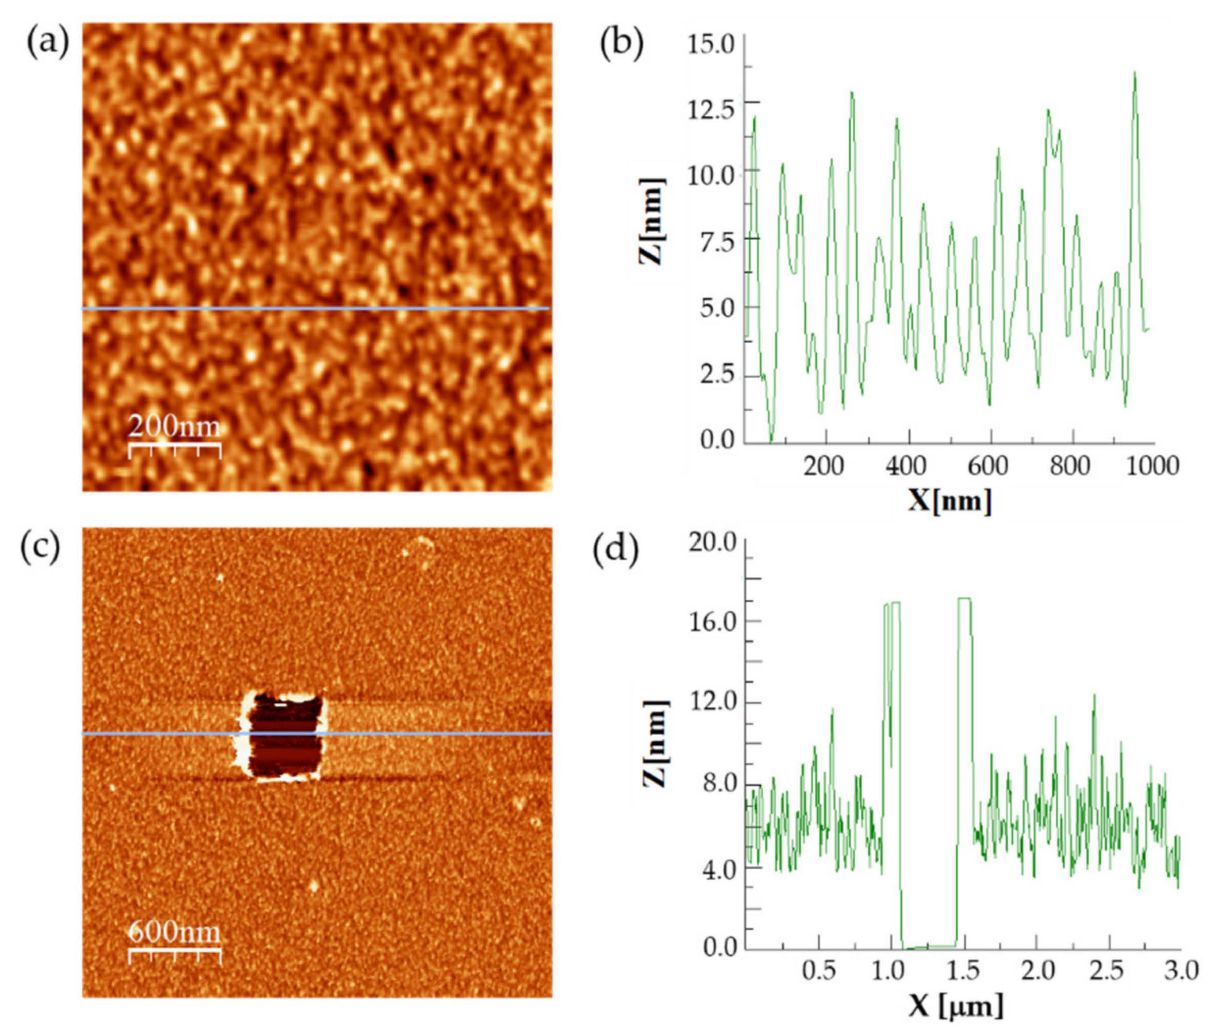
Figure 5. Analysis of the enzymatic samples through AFM. ( a ) Representative AFM topography image of a sub-monolayer Y303S sample used to perform the DFS measurements. ( b ) Height profile of the corresponding blue line in ( a ). ( c ) Topography image of a Y303S sample after scratching an area of 500 × 500 nm. ( d ) Height profile of the corresponding blue line on the center on the scratched area in ( c ), exhibiting a hole corresponding to a monolayer of